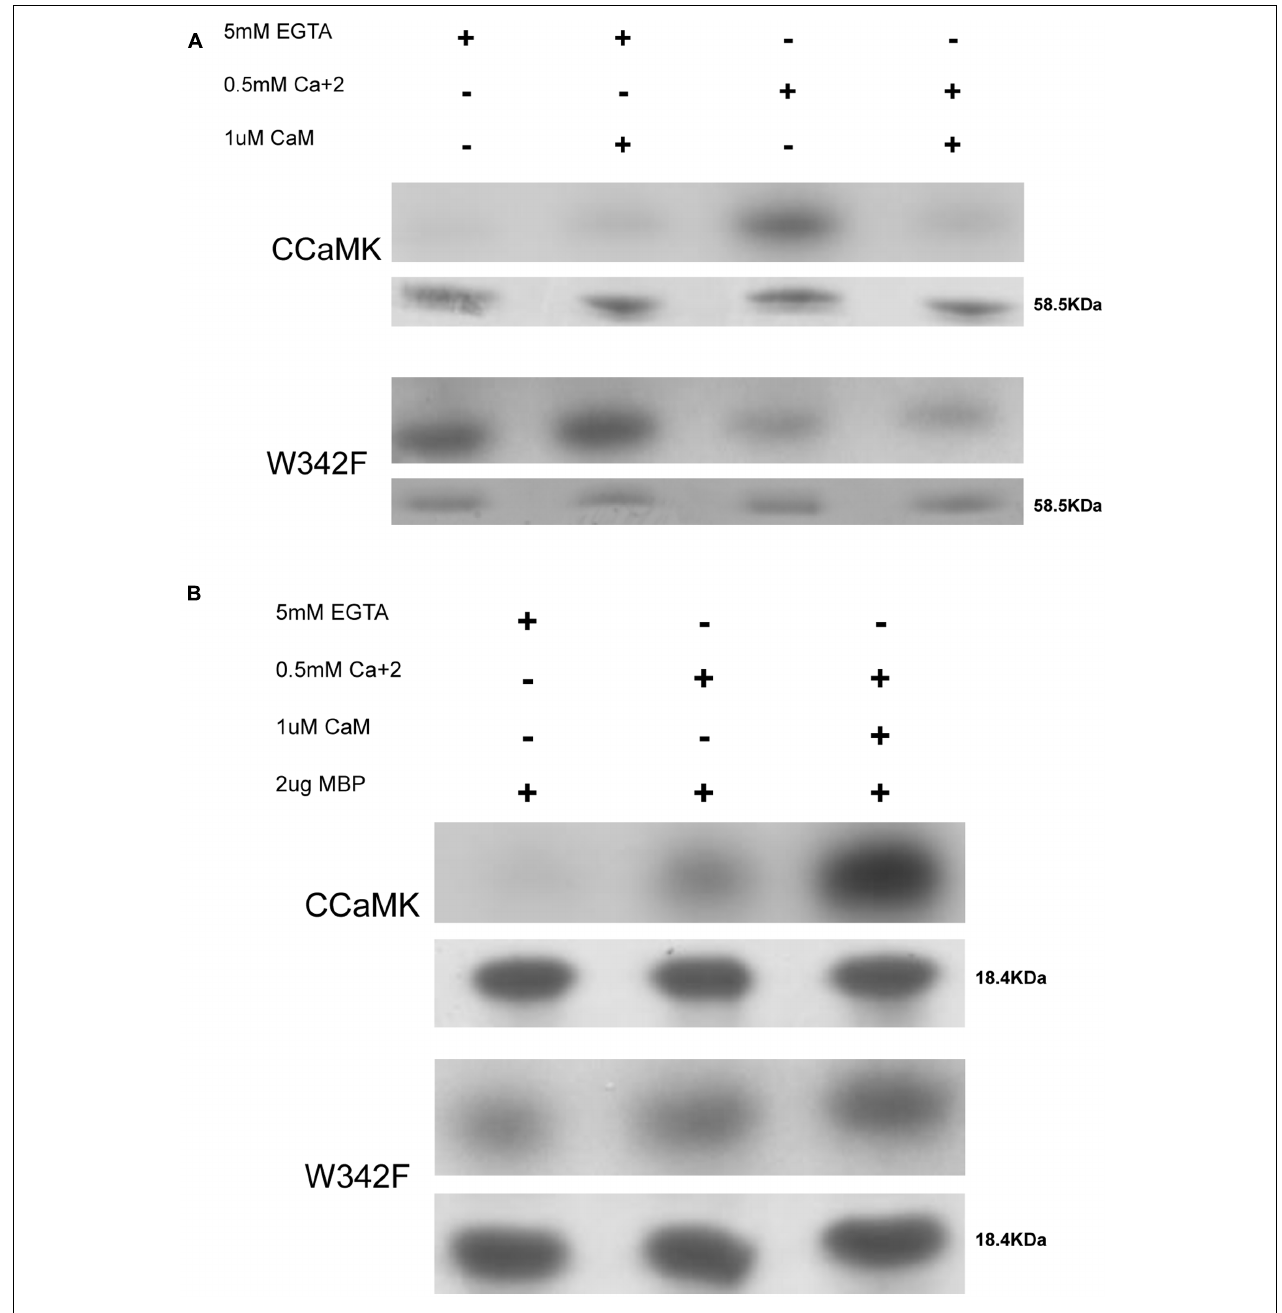
FIGURE 2 | Kinase activity assays of W342F and CCaMK. Autophosphorylation was performed at 30 ◦ C for 30 min. (A) CCaMK did not significantly phosphorylate itself in the absence of Ca 2 + . In the presence of Ca 2 + , CCaMK showed drastically increased autophosphorylation, which remarkably decreased once calmodulin was added. The W342F mutant showed very high levels of autophosphorylation in the absence of Ca 2 + as compared to CCaMK, indicating that the mutant behaves in a Ca 2 + -independent manner. Upper: Autoradiograph film demonstrating the autophosphorylation activity of CCaMK and W432F. Lower: Coomassie staining of the purified proteins from E. coli (BL21) expressing the pET28-CCaMK and W342F. (B) Substrate phosphorylation of CCaMK and W342F. The substrate phosphorylation of CCaMK and W342F was determined in the absence (5 mM EGTA), or presence of Ca 2 + (0.5 mM CaCl 2 ), or Ca 2 + and calmodulin together (0.5 mM CaCl 2 + 1 µ M calmodulin). 2 µ g of bovine myelin basic protein (MBP) was used as the substrate. Substrate phosphorylation of W342F in the absence and presence of Ca 2 + did not follow a similar pattern compared to CCaMK. This mutant displayed a Ca 2 + - and/or calmodulin-independent substrate phosphorylation capacity, but the maximum level of MBP phosphorylation intensity catalyzed by W342F was remarkably lower than substrate phosphorylation intensity catalyzed by CCaMK in the presence of Ca 2 + and calmodulin. The kinase activity assays were repeated three times. Upper: Autoradiograph film showing the substrate phosphorylation activity of CCaMK and W432F; Lower: Coomassie staining of MBP substrate (2 µ g).